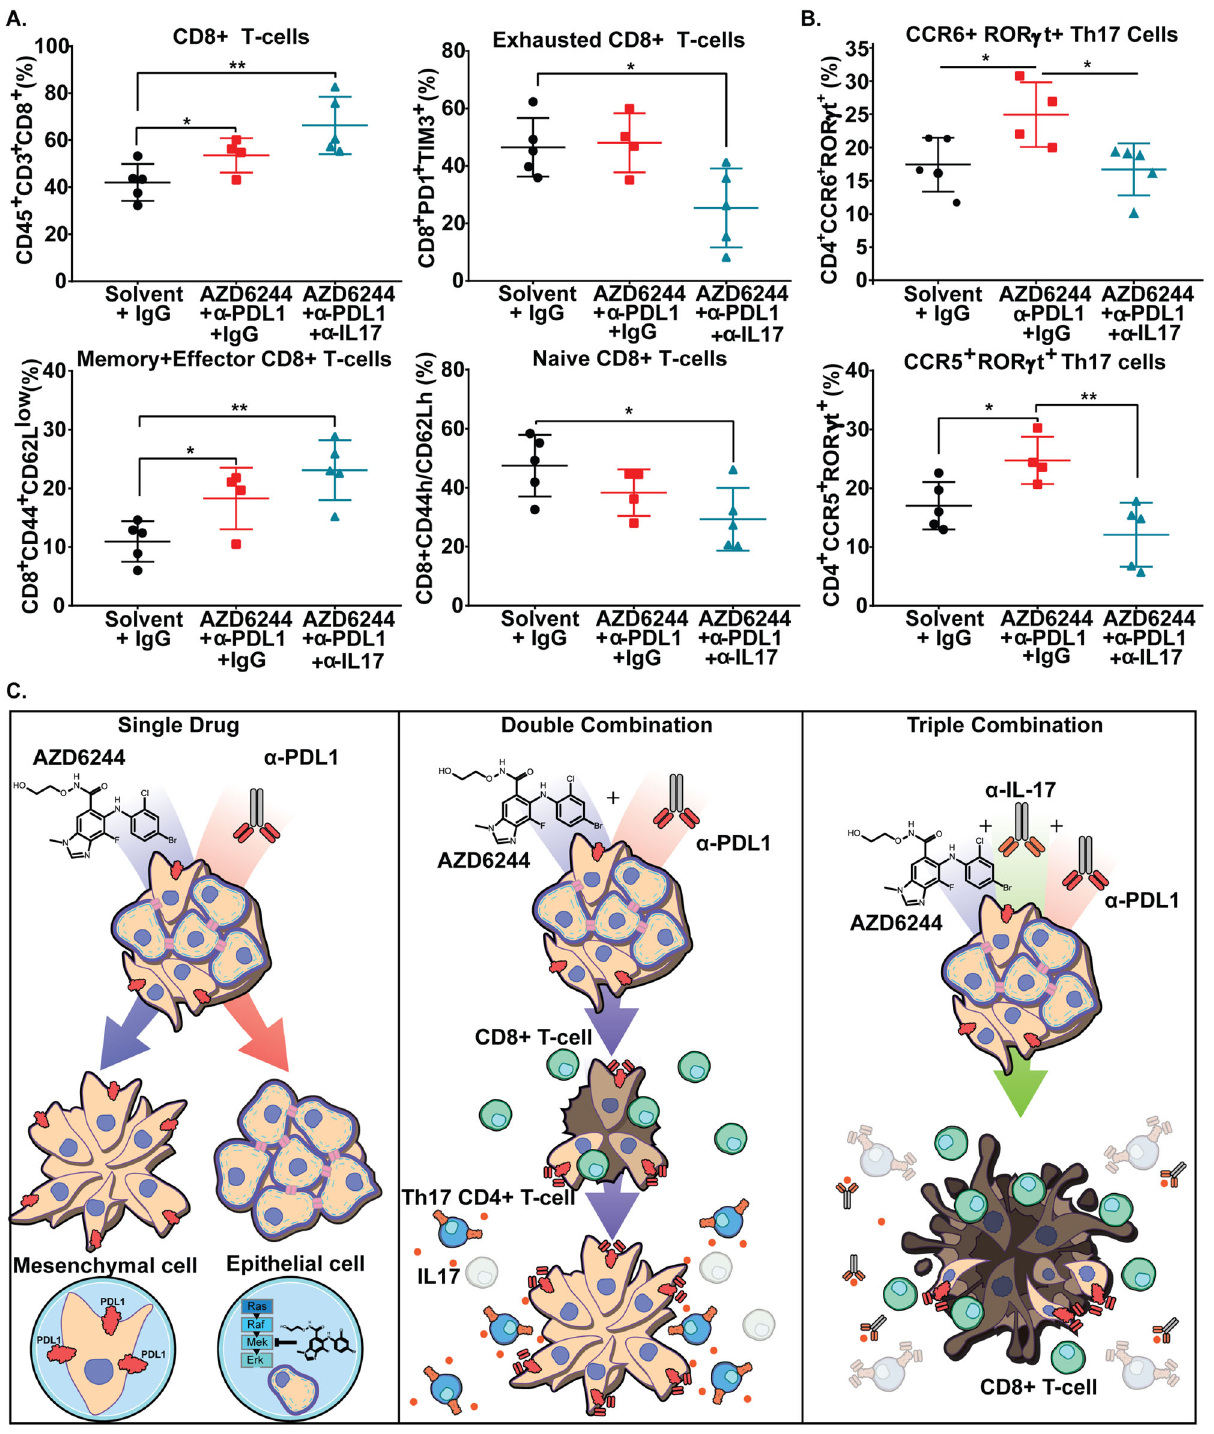
Fig. 7 Neutralizing IL-17 promotes pro-in fl ammatory tumor immune microenvironment. A Percent of CD45 + CD3 + total CD8 + T cells and percentage of exhausted, memory/effector, and naive CD8 + T-cell subpopulations gated by the indicated markers from 344SQ tumors from the experiment in Fig. 6F. Data are presented as mean values ± SD. n = 4 – 5. Data were analyzed using unpaired Students ’ t test. * P < 0.05; ** P < 0.01. B Percent of CCR6 + and CCR5 + ROR γ t + Th17 cells gated from total CD4 + T-cell population. Data are presented as mean values ± SD. n = 4 – 5. Data were analyzed using unpaired Students ’ t test. * P < 0.05; ** P < 0.01. C Proposed working model of MEK inhibitor and anti-PD-L1 combinatorial drug resistance. Initial response to combination therapy promotes CD4 + T-cell differentiation into Th17 cells, which secrete IL-17 and IL-22 to promote resistance to MEK inhibition and PD-L1 blockade. Neutralization of IL-17 in combination with MEK inhibition and PD-L1 blockade abrogates resistant tumor outgrowth.